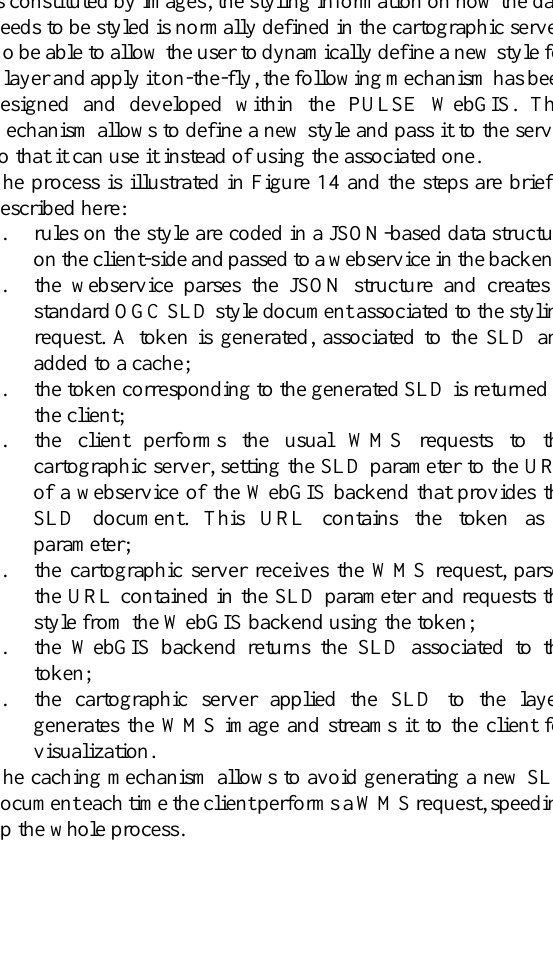
Figure 11. Upload CSV dialog